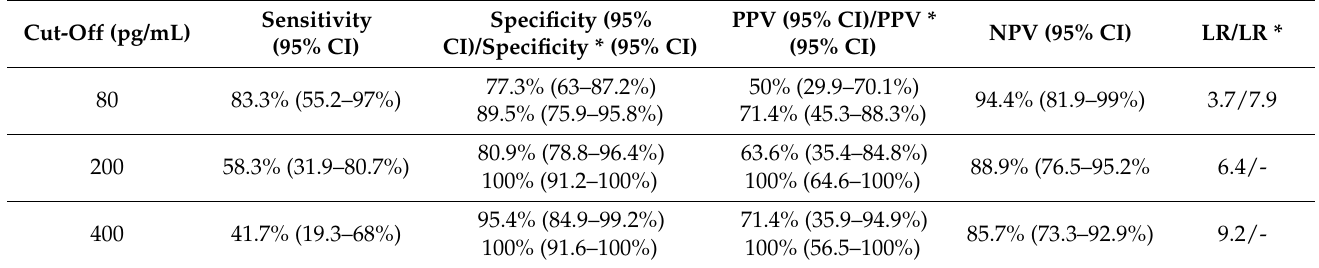
Table 3. Performance of BDG assays for PjP and Pj colonization discrimination in 56 episodes occurring in 56 HIV-negative patients with a Pj low fungal load (<30,000